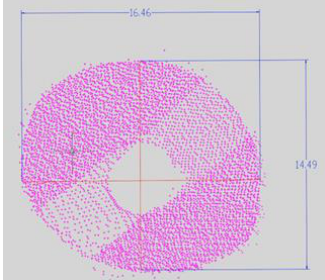
Figure 10. Dimensions of retrieved scour model for Trial 1 (all units are in inches) [35,36] (used with permission).